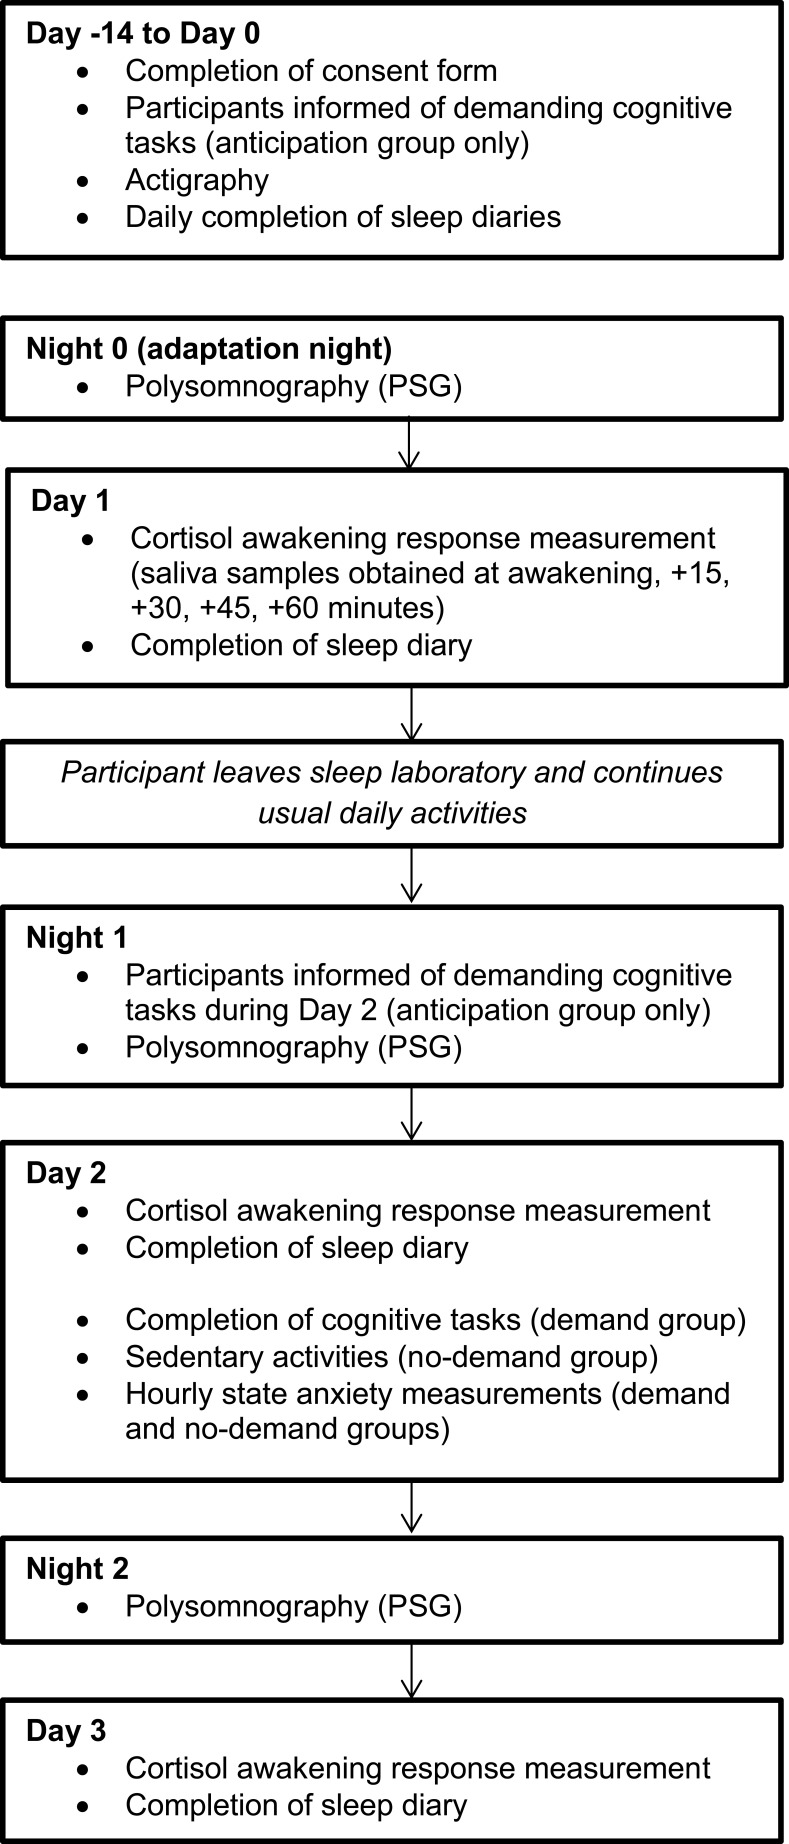
Study schematic.